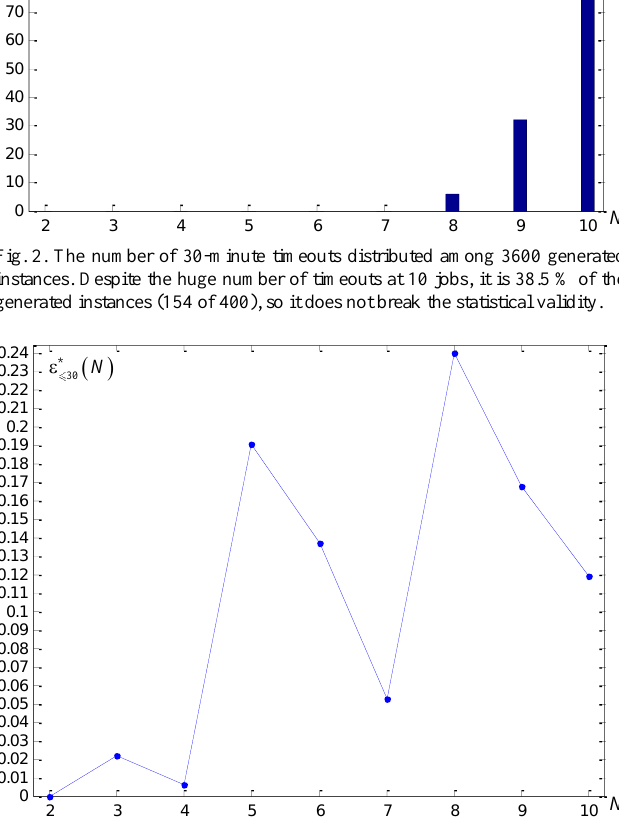
Fig. 3. Regular gap (51) averaged over 400 instances for the number of jobs from 2 to 7, and averaged over 394, 368, and 246 instances of scheduling 8, 9, and 10 jobs, respectively. The peaks may indicate that the number of instances per number of jobs is not sufficiently great. On the other hand, the regular gap itself is very small (although it is not insignificant here) and thus such peaks are unavoidable. After the two sharp peaks, a peak at 11 jobs is likely.